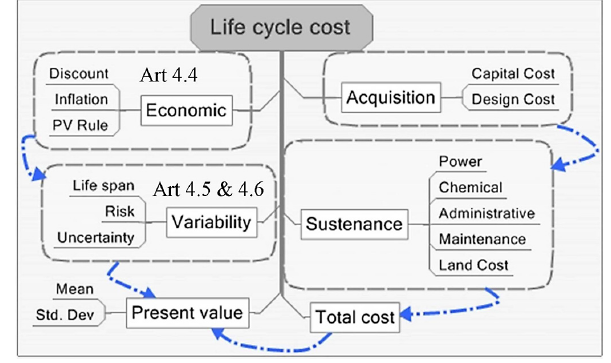
Figure 3. Block diagram for cost